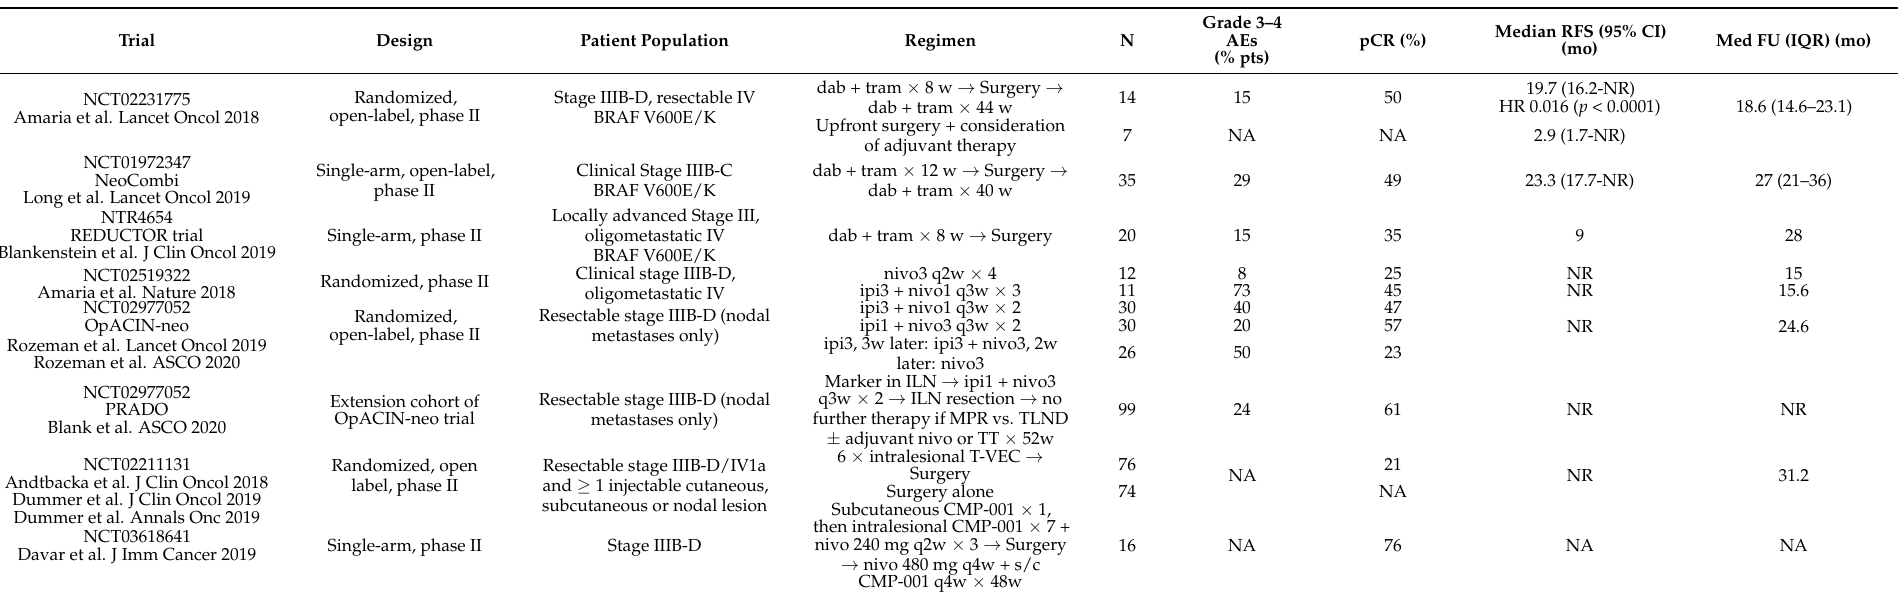
Table 1. Summary of phase II randomized controlled and single-arm trials using neoadjuvant contemporary therapies for resectable stage III/IV